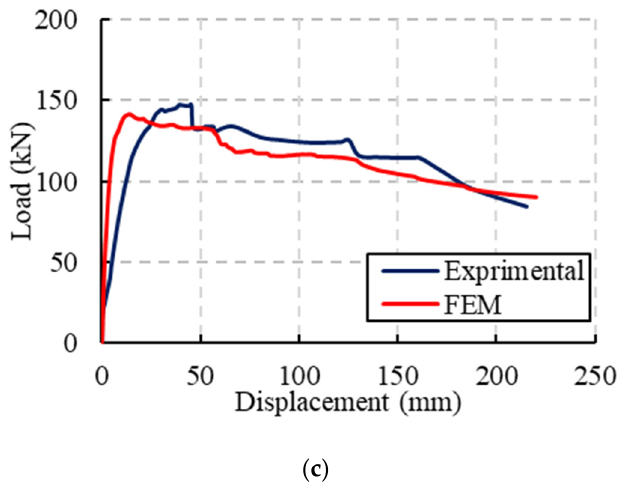
Figure 16. Validations of the FE results for static loading: ( a ) Specimen NR; ( b ) Specimen CG; ( c ) Specimen CGC.